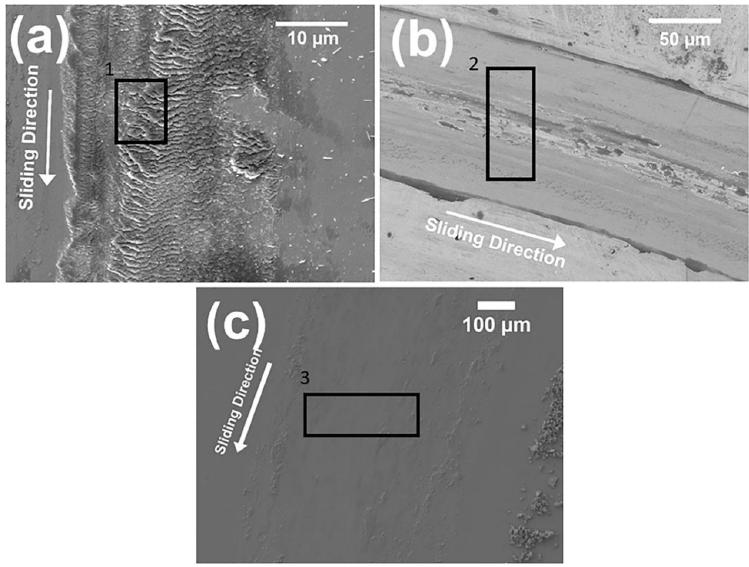
Figure 12. SEM images of the worn surface ( a ) as ‐ deposited film, ( b ) 300 °C annealed film, and ( c ) tribotest at 300 °C [118].